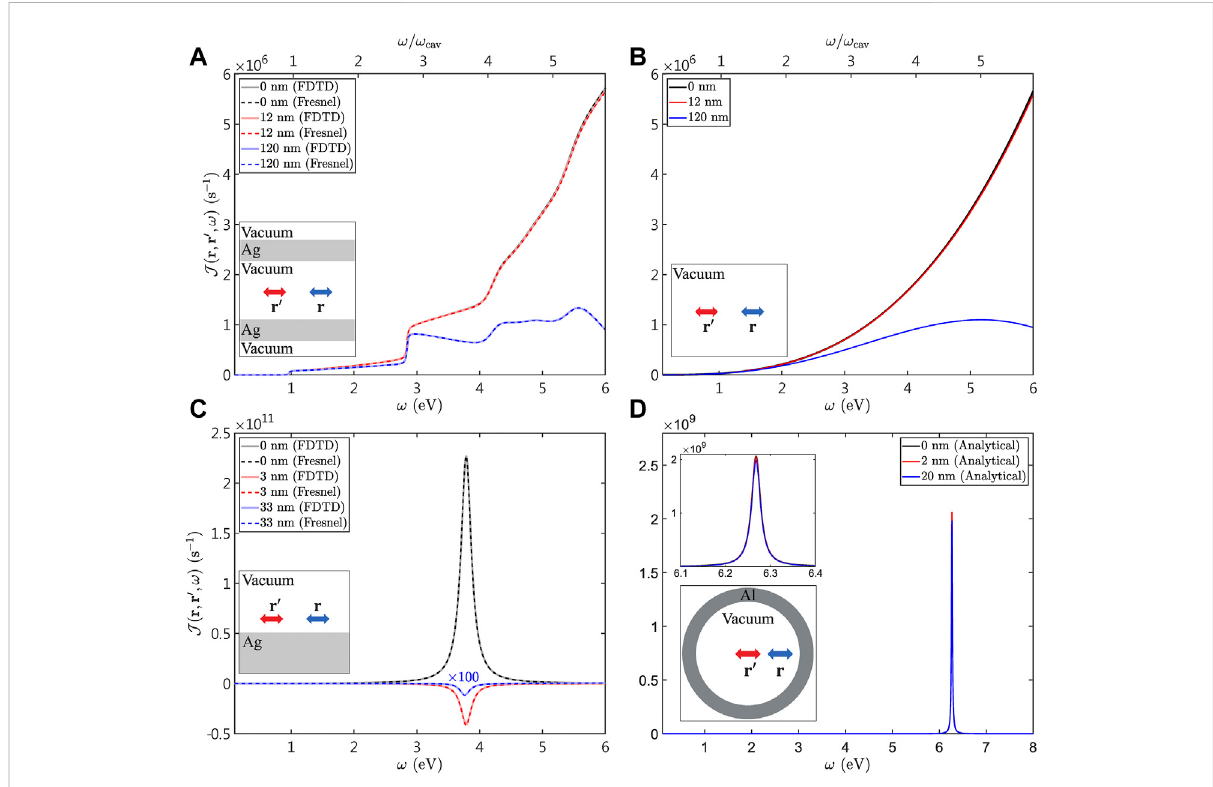
FIGURE 2 Frequency dependence of generalized spectral densities (A) inside a silver Fabry-Pérot cavity, (B) in vacuum, (C) above a silver surface, and (D) inside an aluminum spherical cavity. The magnitude of the transition dipole moments in these systems is set to be 1